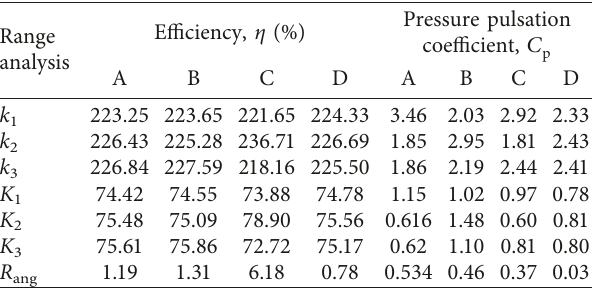
Table 7: Range analysis of the results on shaft power and pressure pulsation